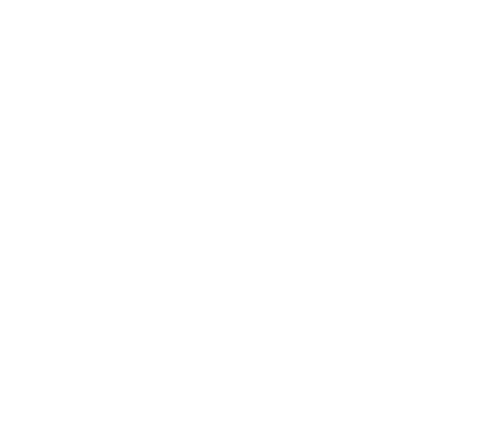
Figure 1. SEC chromatograms of the synthesized P(DMAEMA-co-OEGMA)-1 and P(DMAEMA-co- OEGMA)-2 copolymers in THF/5% v / v Et 3